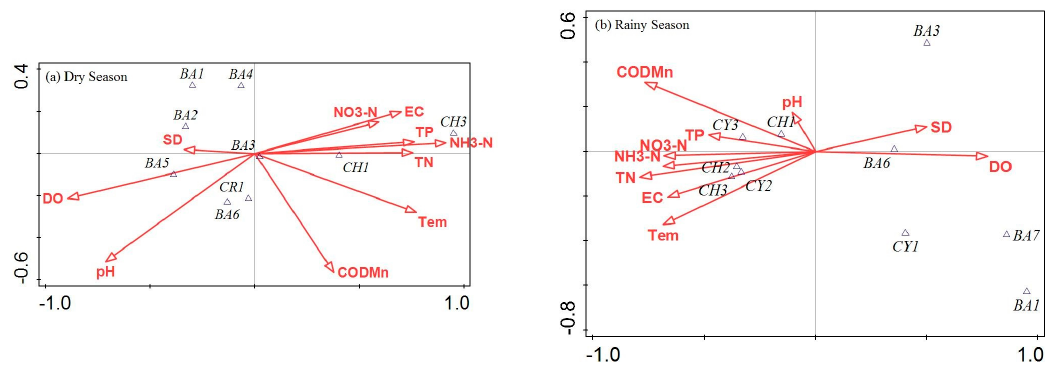
Figure 4 . Plot results of canonical correspondence analysis: the dominant phytoplankton taxa and environmental factors in the ( a ) dry and ( b ) rainy season. The points represent the individual phytoplankton specie and the arrows represent each environmental variable pointing in the direction of its maximum change across the diagram during the study. The taxa are denoted with codes referring Table 2. Table 5. CCA results showing the explained variance (%) of the dominant phytoplankton taxa by canonical